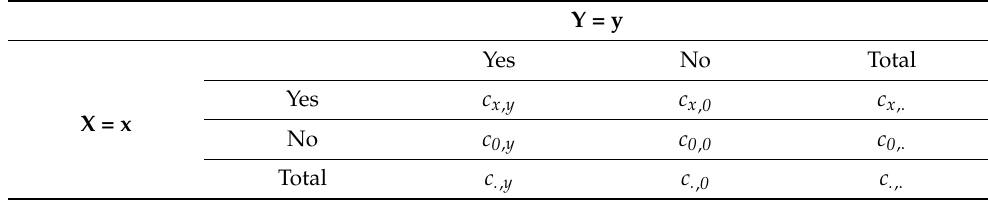
Table A1. Contingency table of co-occurrences between entities X = x and Y = y. This is the basic structure for all scoring schemes. c x , y is the count of the co-occurrence of these entities. c x ,. is the count of the x with all the entities of Y type (e.g., Molecular function). Conversely, c . , y is the count of y with all the entities of X type (e.g.,